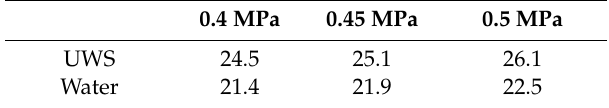
Figure 3. Spray tip penetration for water and UWS for all considered injection pressures (gauge); each curve is an average for five injections.